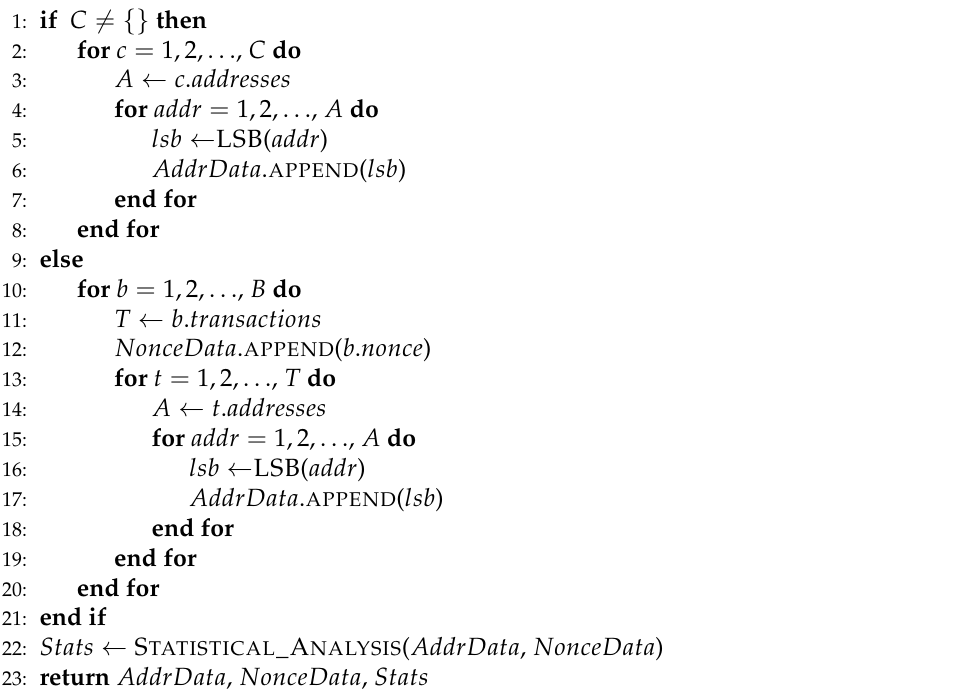
Algorithm 1 Steganographic_Analysis(Blocks B , Clusters C